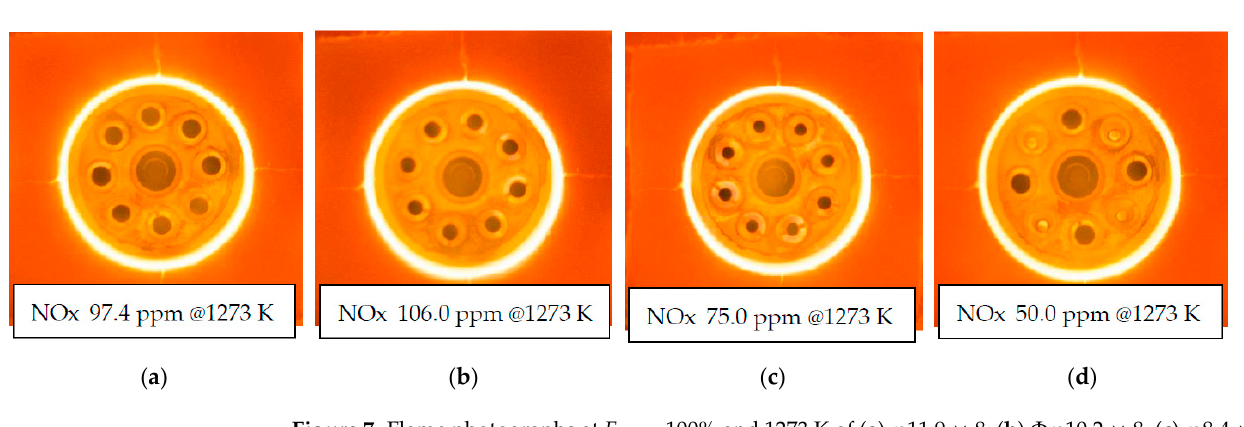
Figure 7. Flame photographs at E H2 = 100% and 1273 K of ( a ) φ 11.9 × 8; ( b ) Φ φ 10.2 × 8; ( c ) φ 8.4 × 8; ( d ) φ 11.9 × 4. Input = 174 kW, λ = 1.2, P = +15 Pa.